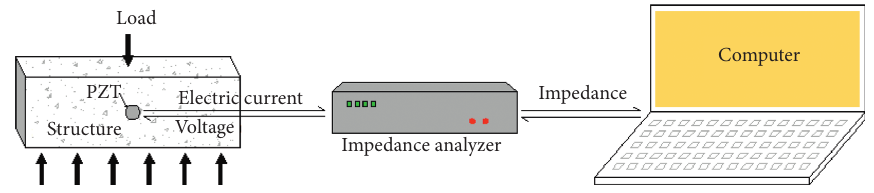
Figure 1: Diagrammatic sketch of the EMI operational process.